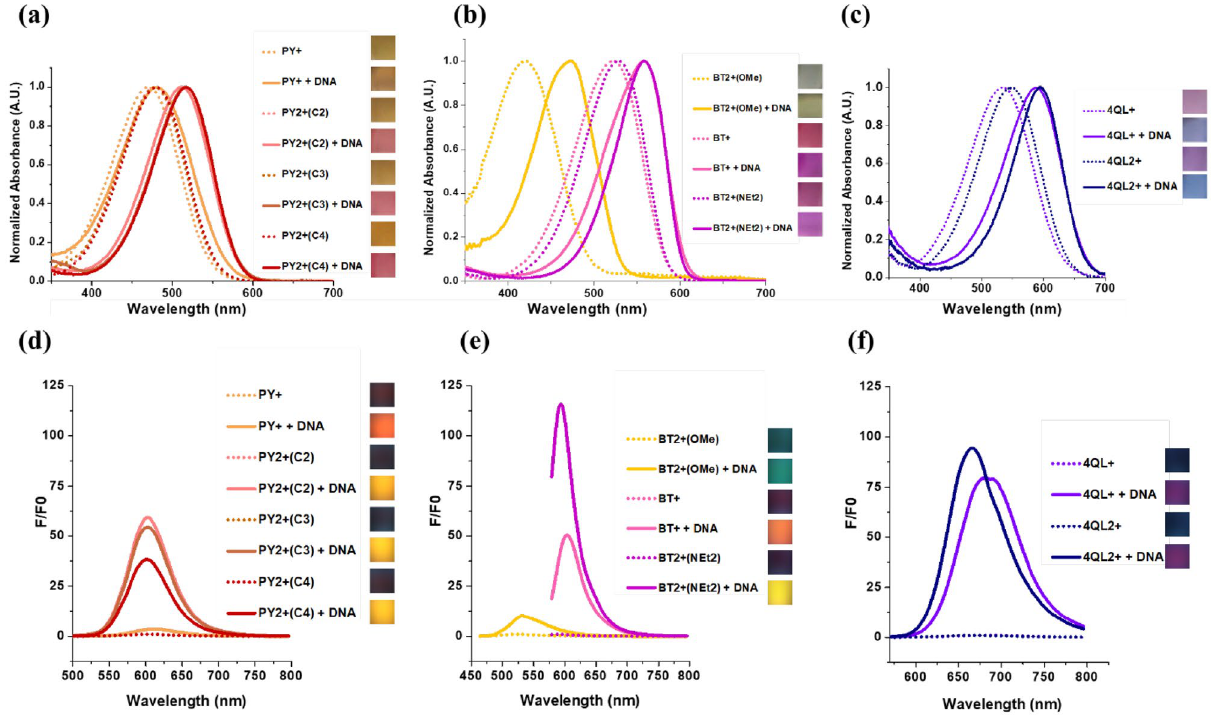
Figure 2. Normalized absorption ( a – c ) and fluorescence spectra ( d – f ) of cationic styryl dyes in the PY series ( a , d ), BT series (b,e), and 4QL series ( c , f ) in the absence and presence of DNA. Conditions: [Dye] = 10 μM (or 1 μM for fluorescence studies of BT + and BT2 + (NEt 2 ) ), [DNA(in bp)] = 450 μM (or 45 μM for fluorescence studies of BT + and BT2 + (NEt 2 ) ). Inset: colors of the dyes in daylight (absorption) and under UV illumination (365 nm) in the absence and presence of DNA. Conditions: [Dye] = 50 μM, [DNA (in bp)] = 2,250 μM. All experiments were performed in 10 mM sodium phosphate buffer pH 7.0. Excitation wavelengths BT2+(OMe) λ ex = 450 nm, PY+ , PY2+(C2) , PY2+(C3) , PY2+(C4) λ ex = 480 nm, BT+ , BT2+(NEt 2 ) λ ex = 565 nm , 4QL+ , 4QL2+ λ ex = 548